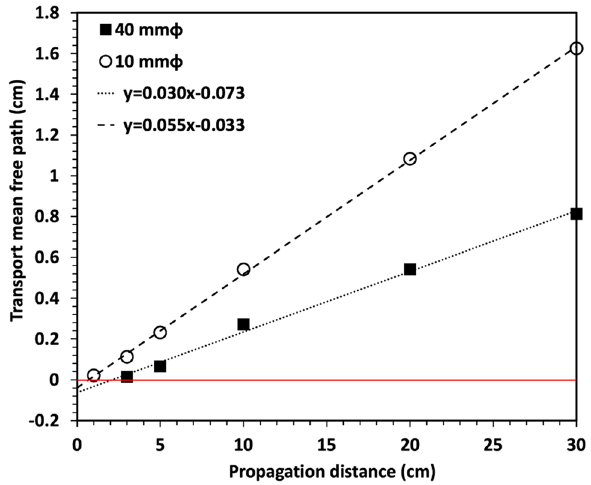
Figure 5. Relationship between the transport mean free path and relative propagation distance obtained from annular beams of 40 mm (squares) and 10 mm (open circles)